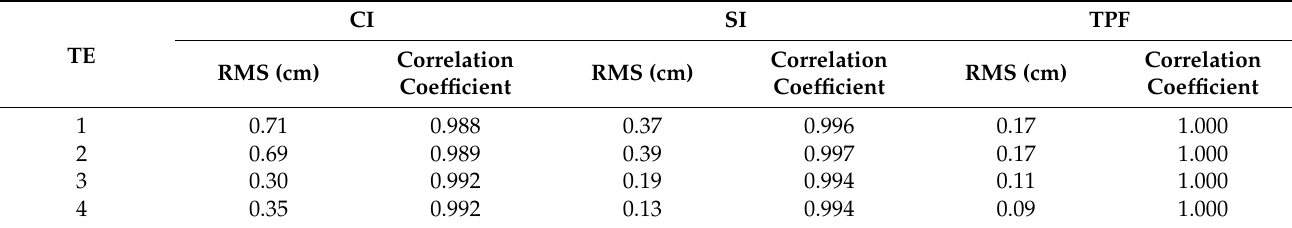
Table 1. RMS errors and correlation coefficients of TE 1–4.